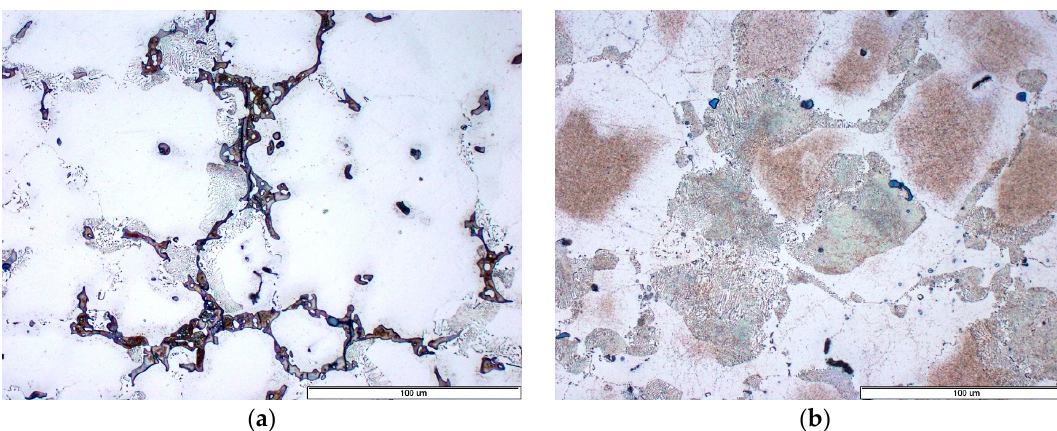
Figure 7. Microstructure of AZ91 alloy after modification with wax-CaF 2 -carbon powder: ( a ) as-cast, ( b ) heat-treated.